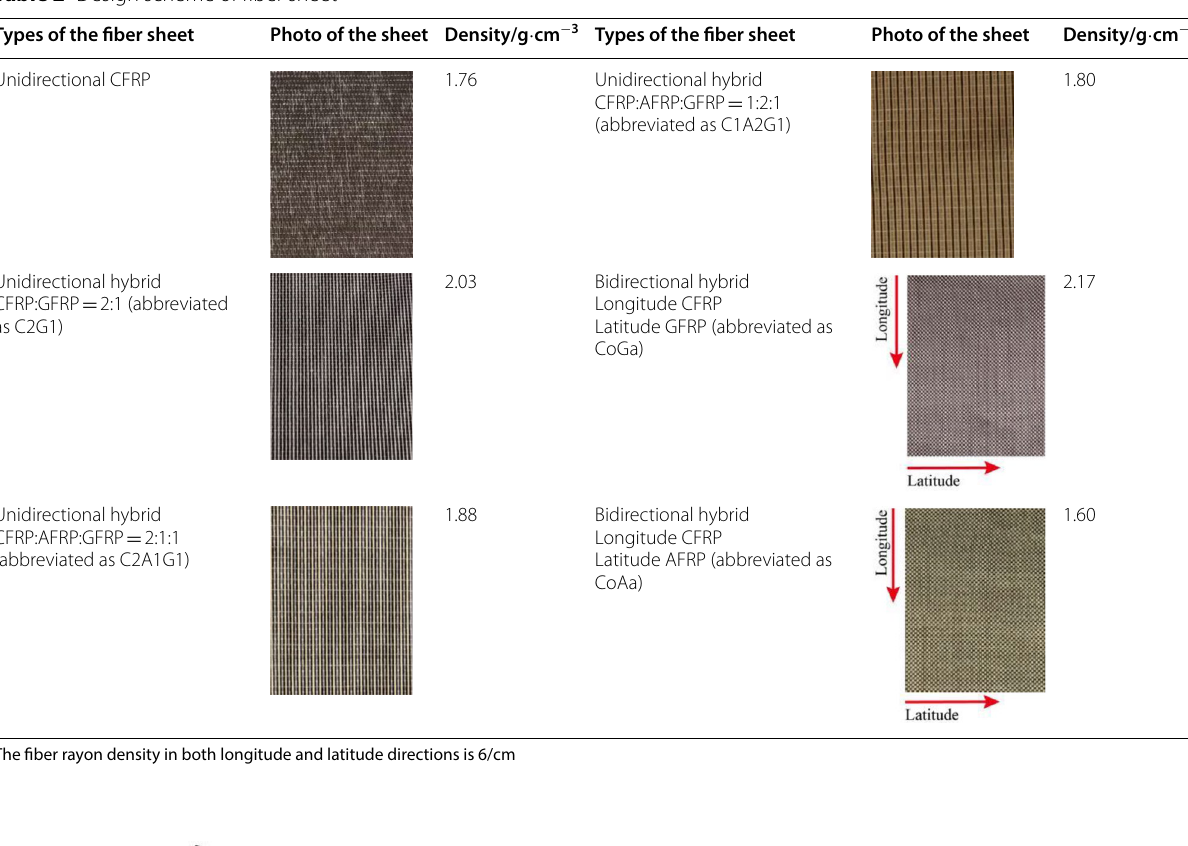
Table 2 Design scheme of fiber sheet Types of the fiber sheet Photo of the sheet Density/g